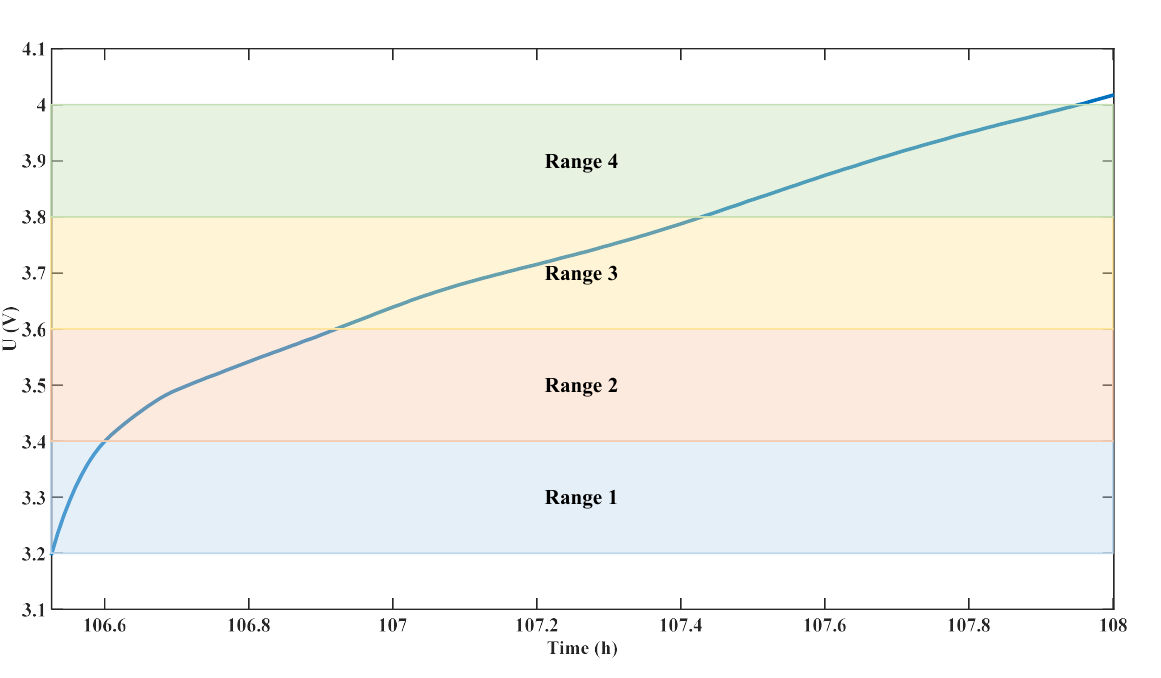
Figure 11. Method for dividing voltage ranges at different